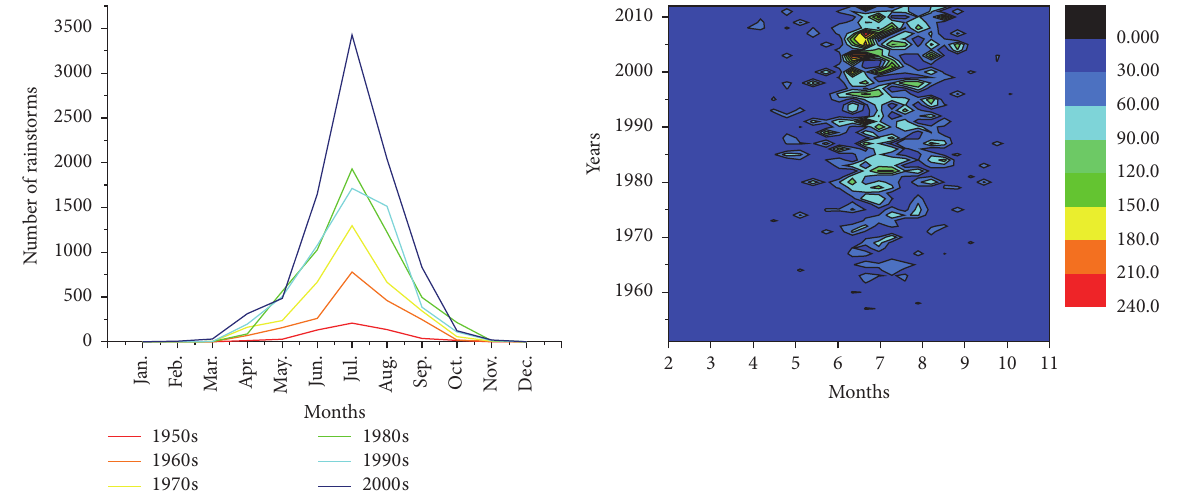
Figure 4: Monthly variation of rainstorm process by